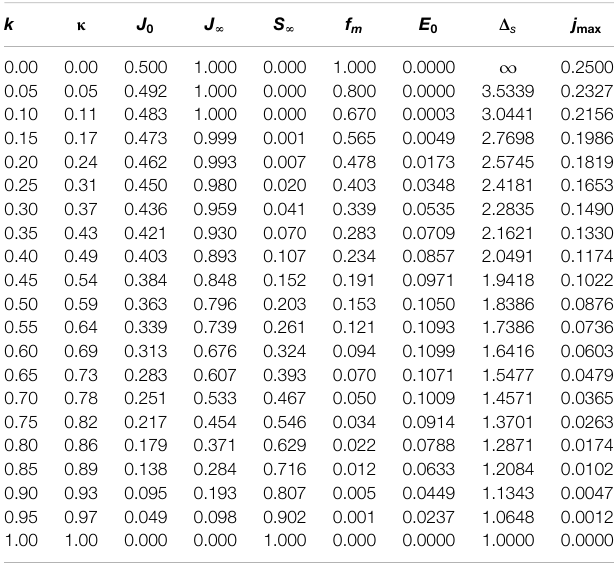
TABLE 1 | Exact parameter values depending on the inverse basic reproduction number k .